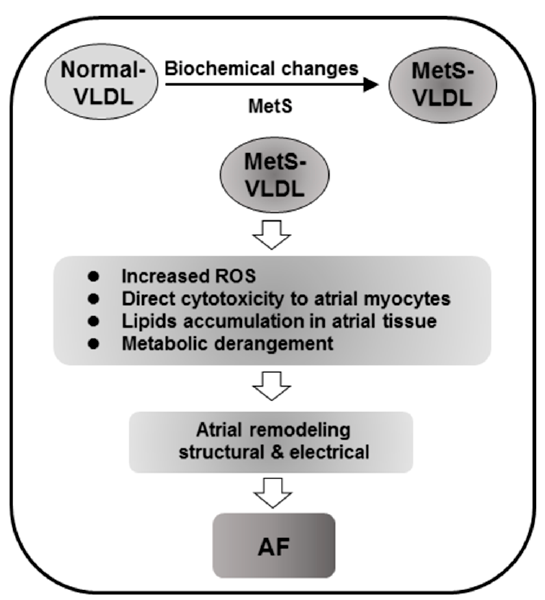
Figure 6. Potential mechanism by which VLDL promotes AF in MetS. In MetS, the biochemical properties of VLDL are changed. MetS-VLDL can induce cellular reactive oxygen species, atrial myocyte cytotoxicity, and excess lipid accumulation resulting in subsequent gene dysregulation corresponding to metabolic derangement. Structural and potentially electrical remodeling initiated by MetS-VLDL in concert contribute to AF vulnerability and development.